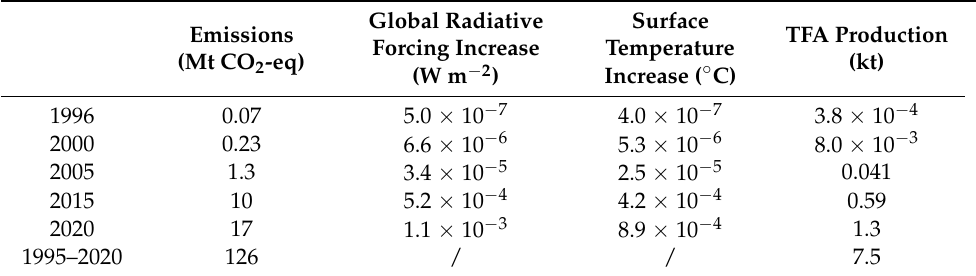
Table 1. The HFC-134a emissions, global radiative forcing increase, surface temperature increase, and TFA production in the North China